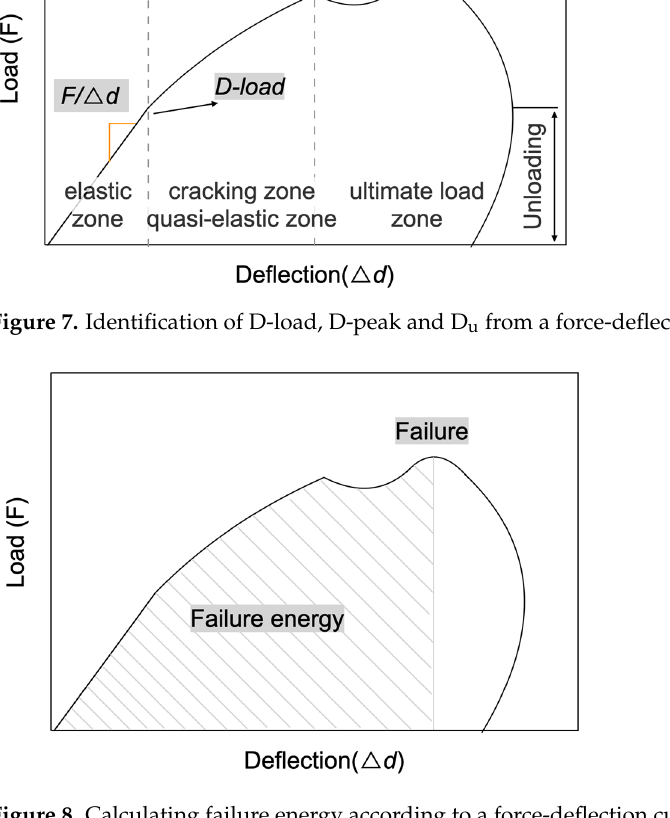
Figure 8. Calculating failure energy according to a force ‐ deflection curve of an RCP.